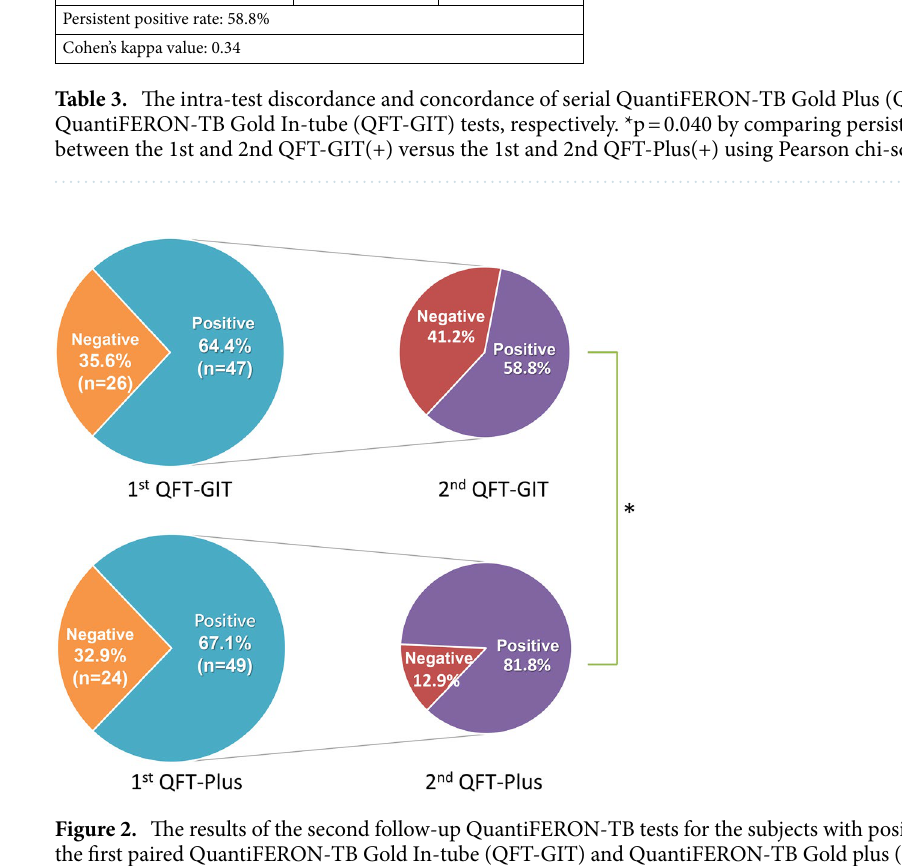
(Table 4) and that of the QFT-GIT 1 (3.68 ± 2.47 vs. 0.98 ± 0.81, p < 0.001) were higher in patients with persistent positivity than in those with negative reversion of QFT-GIT 2 . The T1 and T2 responses of the QFT-Plus 1 were also higher in those with persistent positivity than in the negative reversion group. But the T2–T1 levels of sub- sequent QFT-Plus 1 tests were not significantly different between the persistent positivity and negative reversion groups.